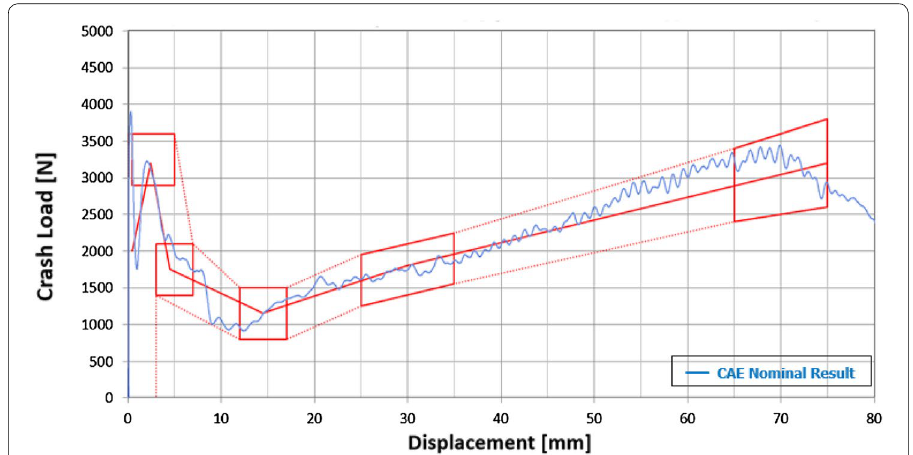
Fig. 3 Quasi‑static simulation result with target response and